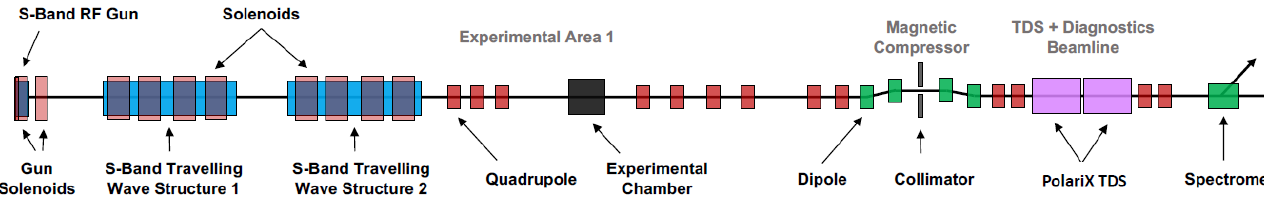
Figure 1. Future layout of the ARES linac at